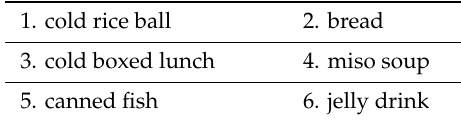
Table A3. Q3. Please circle the items that are di ffi cult to chew / swallow for the elderly (please circle all that